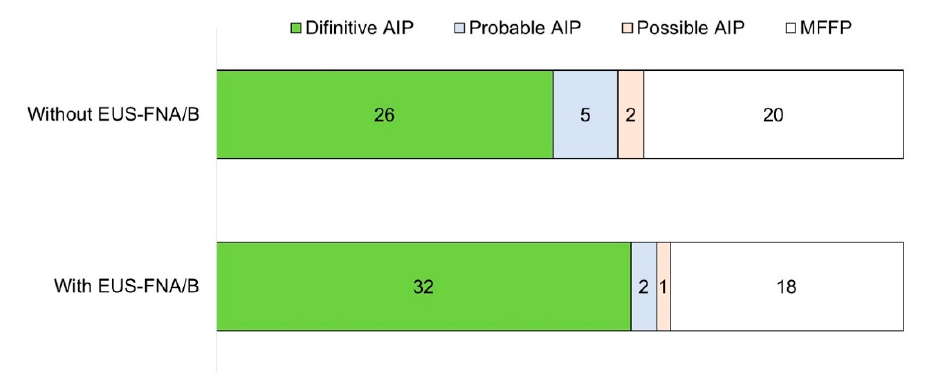
Figure 2. Comparison of diagnosis with and without considering the pathological findings of EUS-FNA/B. EUS-FNA/B, Endoscopic ultrasonography-guided fine needle aspiration/biopsy.